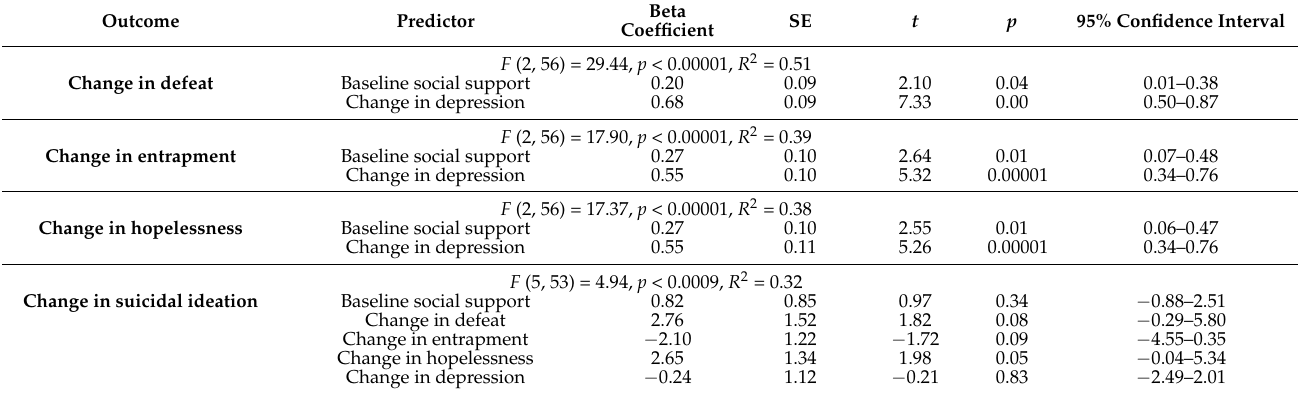
Table 3. Direct and indirect effects of social support on changes in suicidal ideation via defeat, entrapment, and